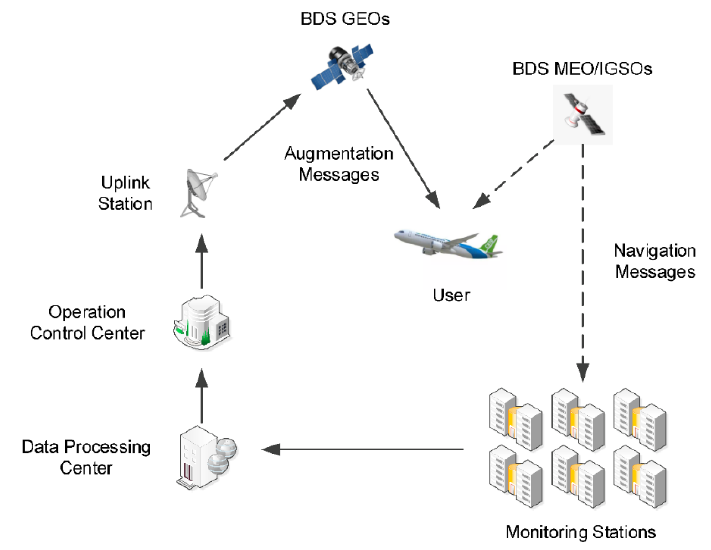
Figure 1. Architecture of BDSBAS.